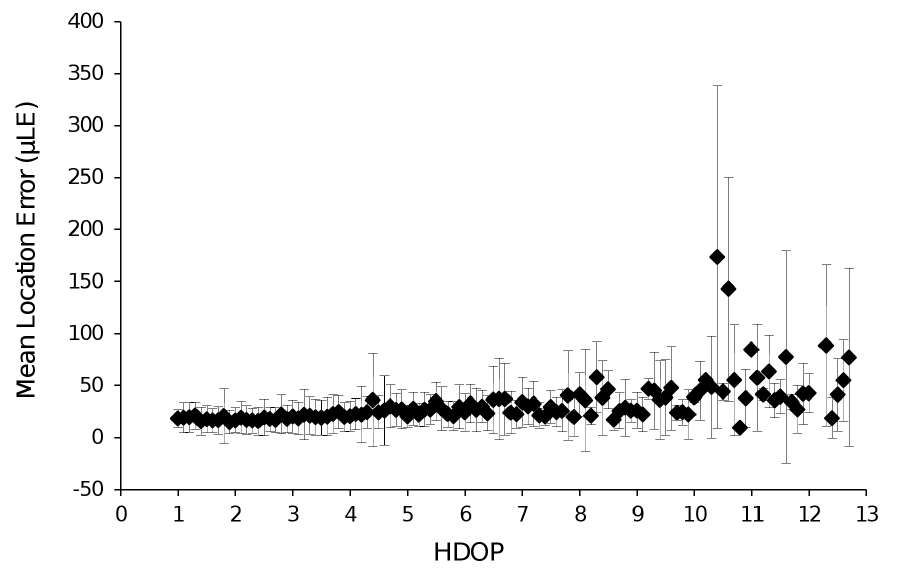
Figure 2. Mean location error ( m LE 6 SD) for each HDOP value. Mean location error ( m LE 6 SD) for each HDOP value for lightweight GPS collars across all suburban habitats and sky availability classes, Dunedin.